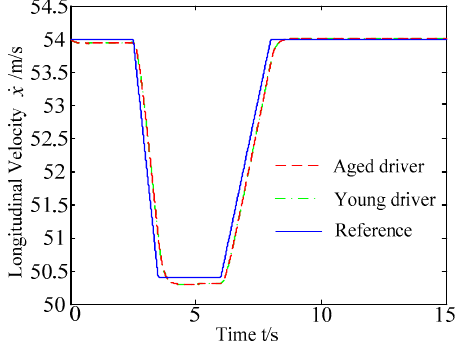
Figure 21. Longitudinal velocities of vehicle p under di ff erent handling characteristics.